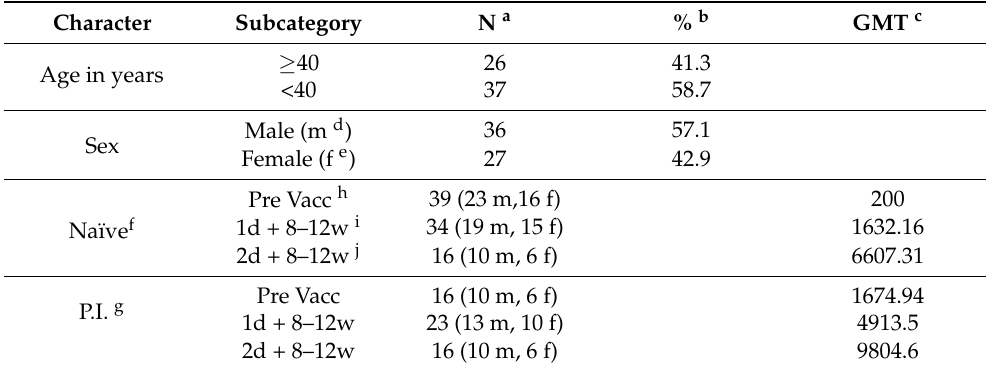
Table 1. Baseline characteristics and serostatus of study participants ( n = 63) and longitudinal humoral immune